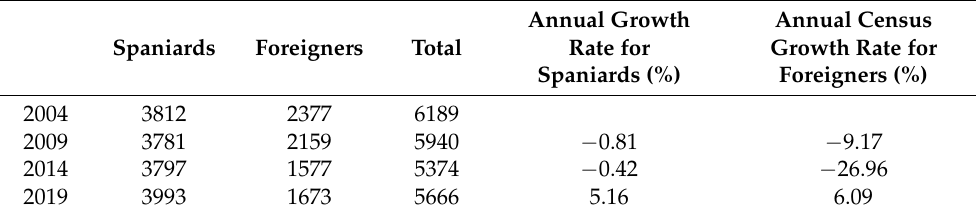
Table 3. Population of El Terreno. Source: Own elaboration based on statistics data from the Statistical Institute of the Balearic Islands (IBESTAT).